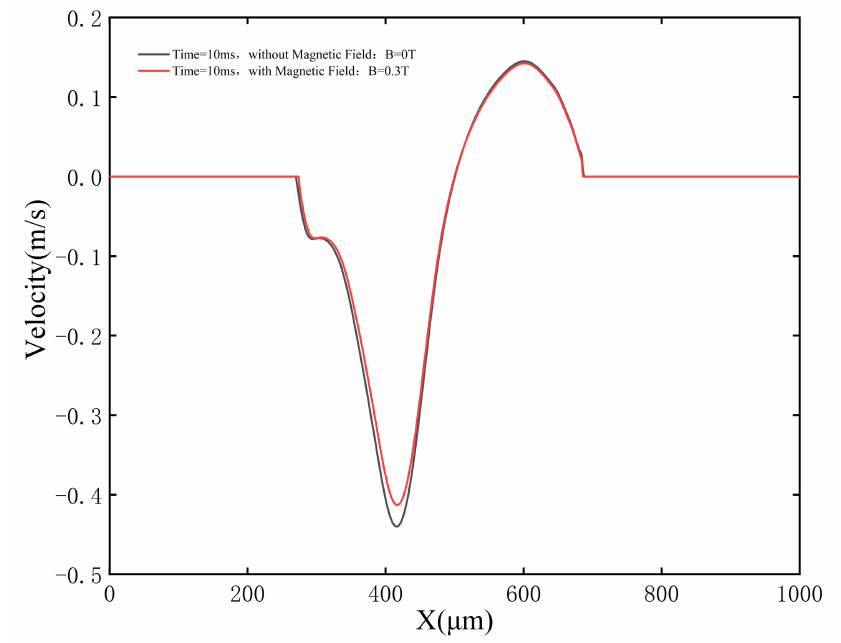
Figure 15. The velocity at the top of the molten pool with and without application of magnetic field at t = 10